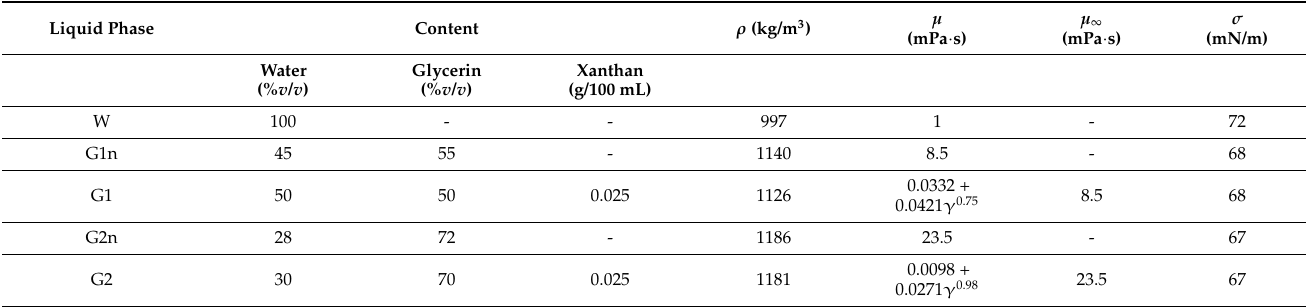
Table 1. Properties of the studied Newtonian and non-Newtonian fluids.